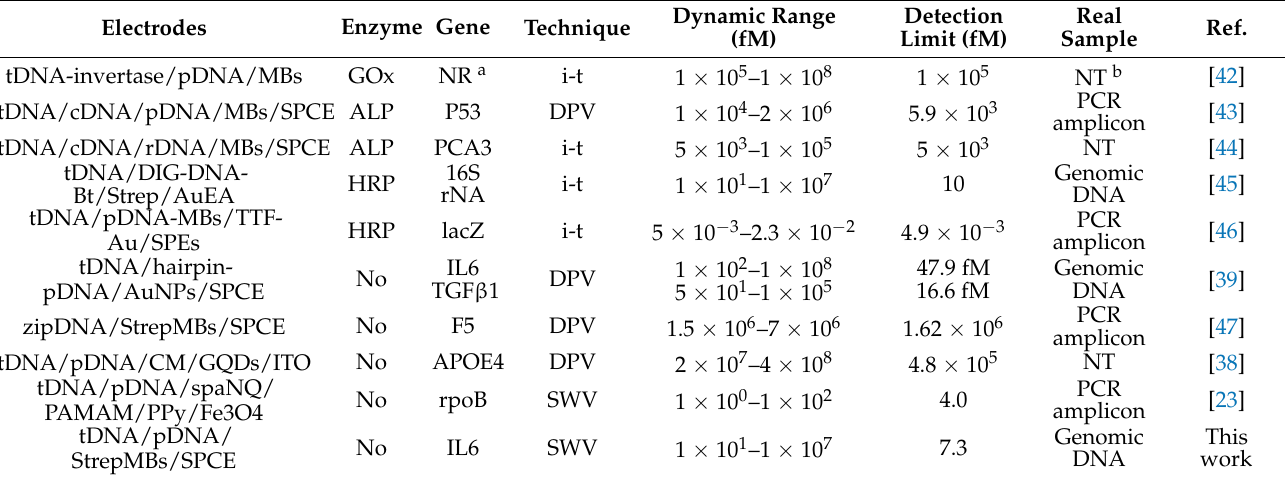
Table 3. Selected set of electrochemical DNA sensors for detecting mutations in DNA. Electrodes Enzyme Gene Technique